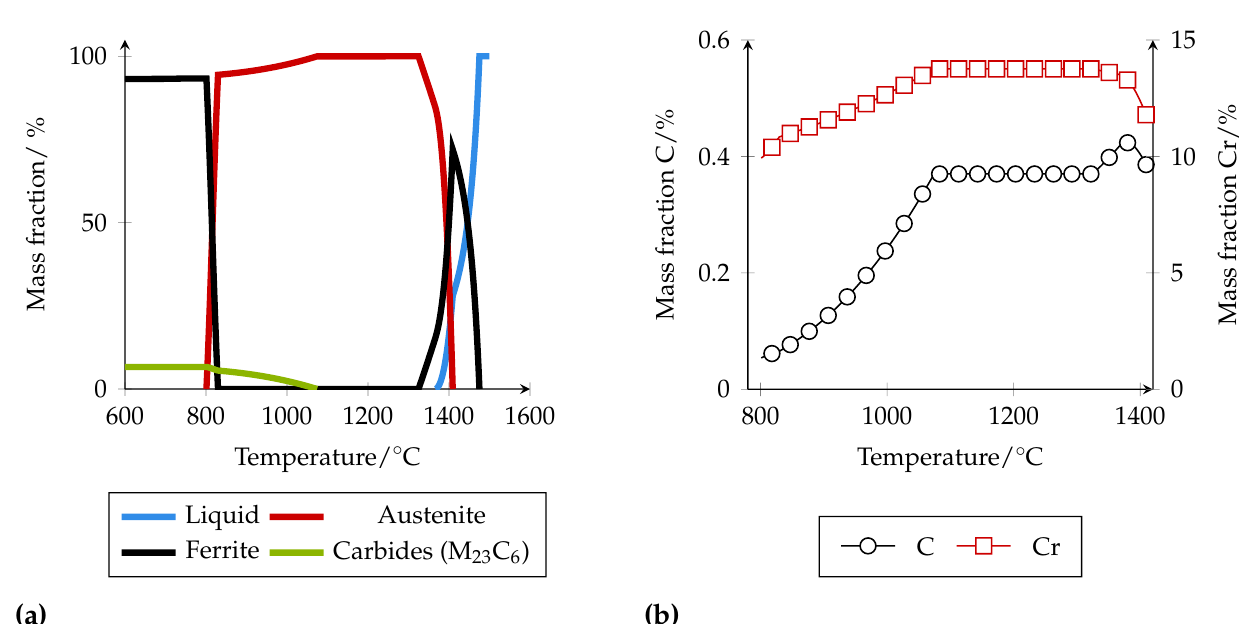
Figure 6. Thermodynamically calculated phase composition ( a ) and local chemical composition of austenite ( b ) in equilib-